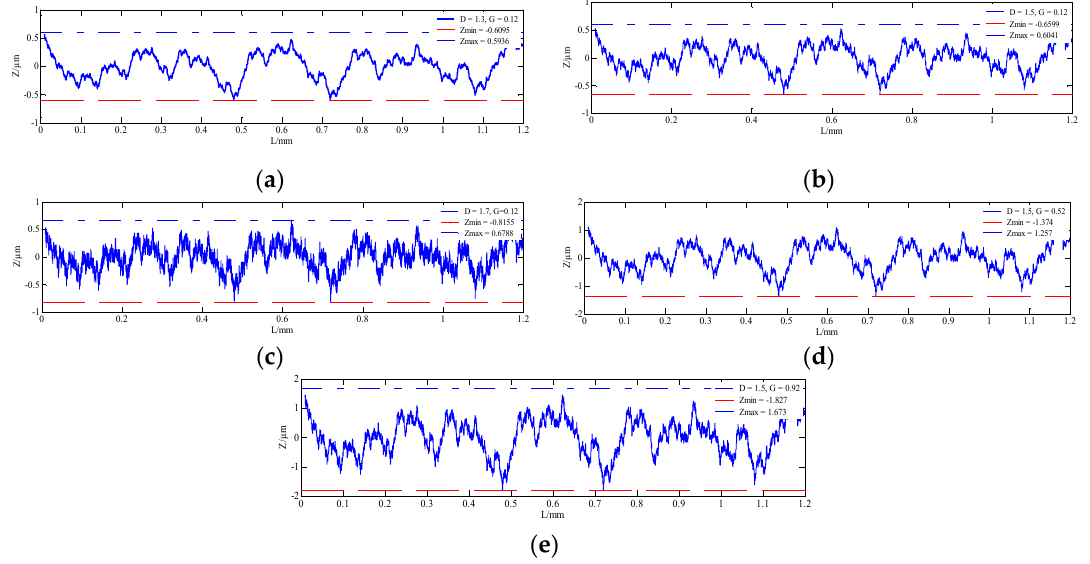
Figure 10. Two-dimensional rough surface curves with different D and G ( a ) D = 1.30, G = 0.12; ( b ) D = 1.50, G = 0.12; ( c ) D = 1.70, G = 0.12; ( d ) D = 1.50, G = 0.52. and ( e ) D = 1.50, G = 0.92.